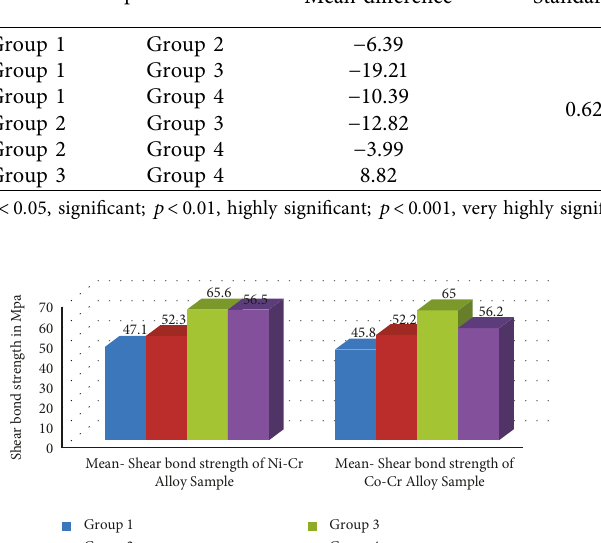
Table 4: Post hoc comparison between groups based on shear bond strength of Co-Cr alloy samples using post hoc Tukey’s tests. Group